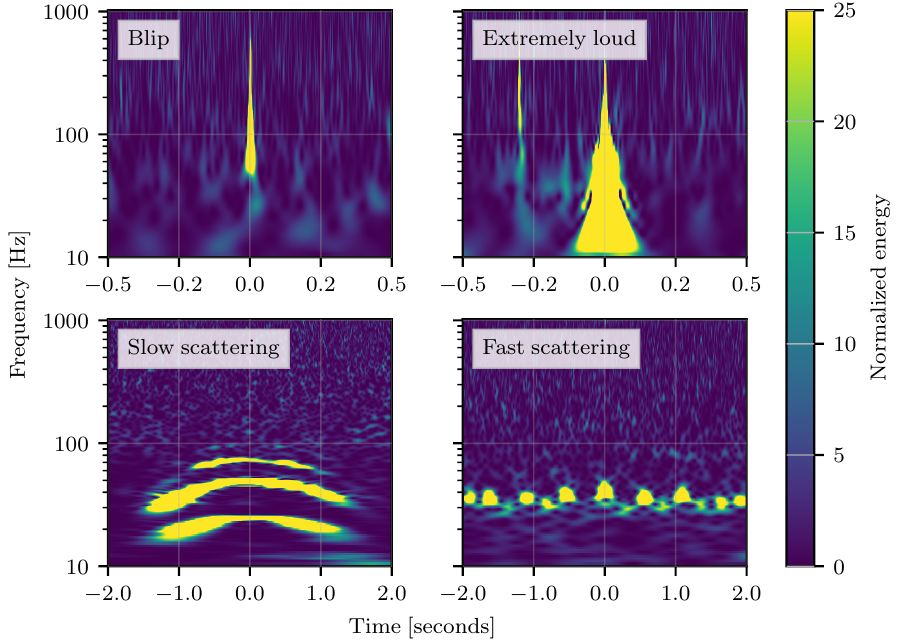
Figure 3. This figure presents Qscans of four common glitch classes present in the LIGO detectors. The glitches’ distinct visual appearance in the scans enables them to be categorized visually or through machine learning algorithms. Figure reproduced from [18]. © IOP Publishing.